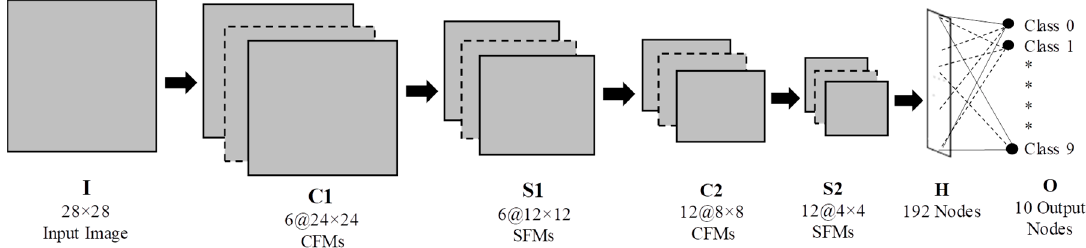
Figure 2. Structure of CNN used in the proposed SEWM-CNN method for